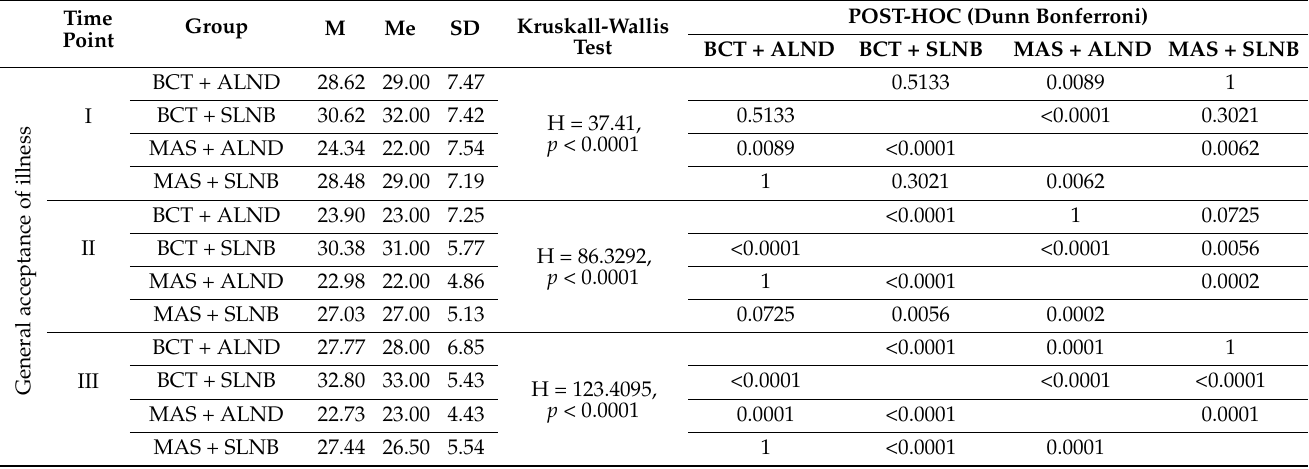
Table 3. Acceptance of illness in breast cancer patients and the relationships between the groups (MAS + SNB, MAS + ALND, BCT + SNB, BCT + SNB) and assessment time points.